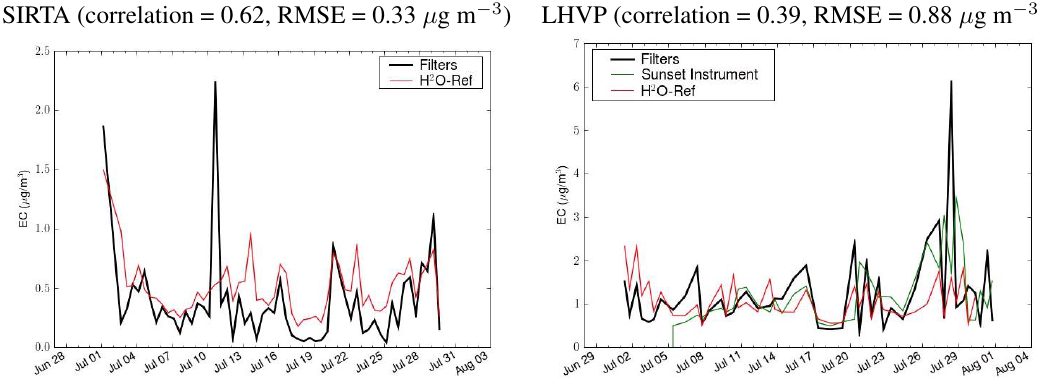
Fig. 4. 12 h averaged concentrations of EC modeled with “H 2 O-Ref” and measured with filters at the SIRTA site (left) and with both filters and Sunset filed instrument at the LHVP (right) site (correlations and RMSE are between the model and the filter measurements). (2011) to be one of the main sources of organic aerosols in the Paris city